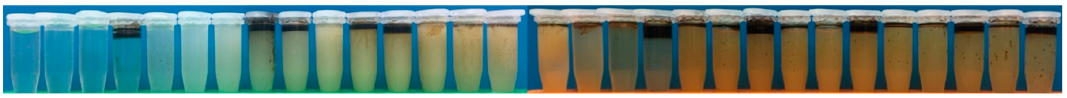
Figure 9. Photo images of the effluent fluid which was collected from the more permeable oil reservoir during the core flooding experiment.